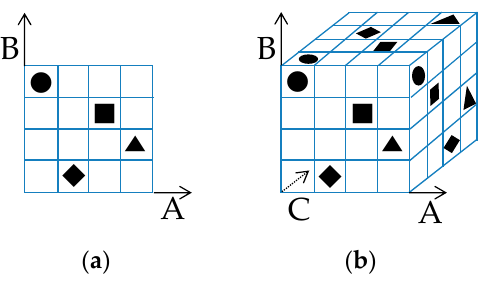
Figure 9. Latin hypercubes: ( a ) Two factors (A, B) and four levels; ( b ) three factors (A, B, C) and four levels.